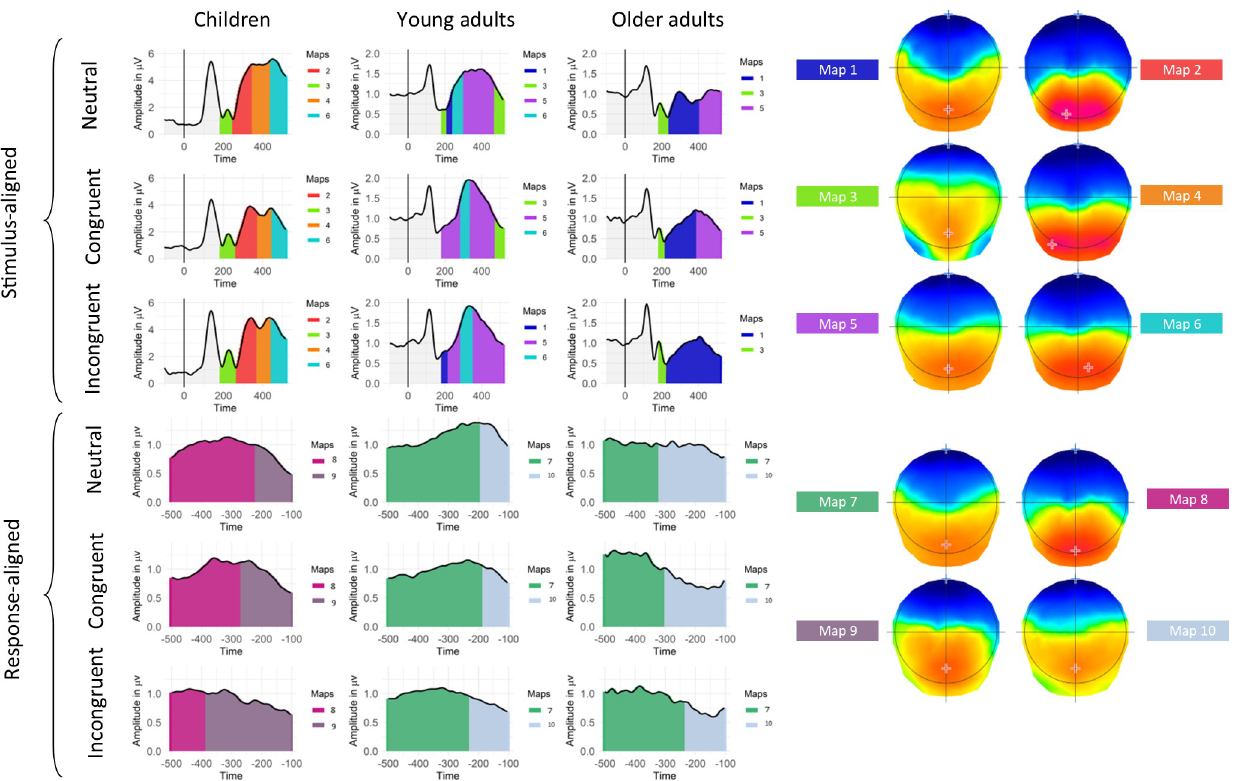
Fig 4. Periods of stability of the electric field at the scalp are represented under the GFP curve of the grand average ERPs with color codes for stimulus-and-response-aligned signal, for each age group and condition. The corresponding template maps are displayed on a continuum from red (positive) to blue codes